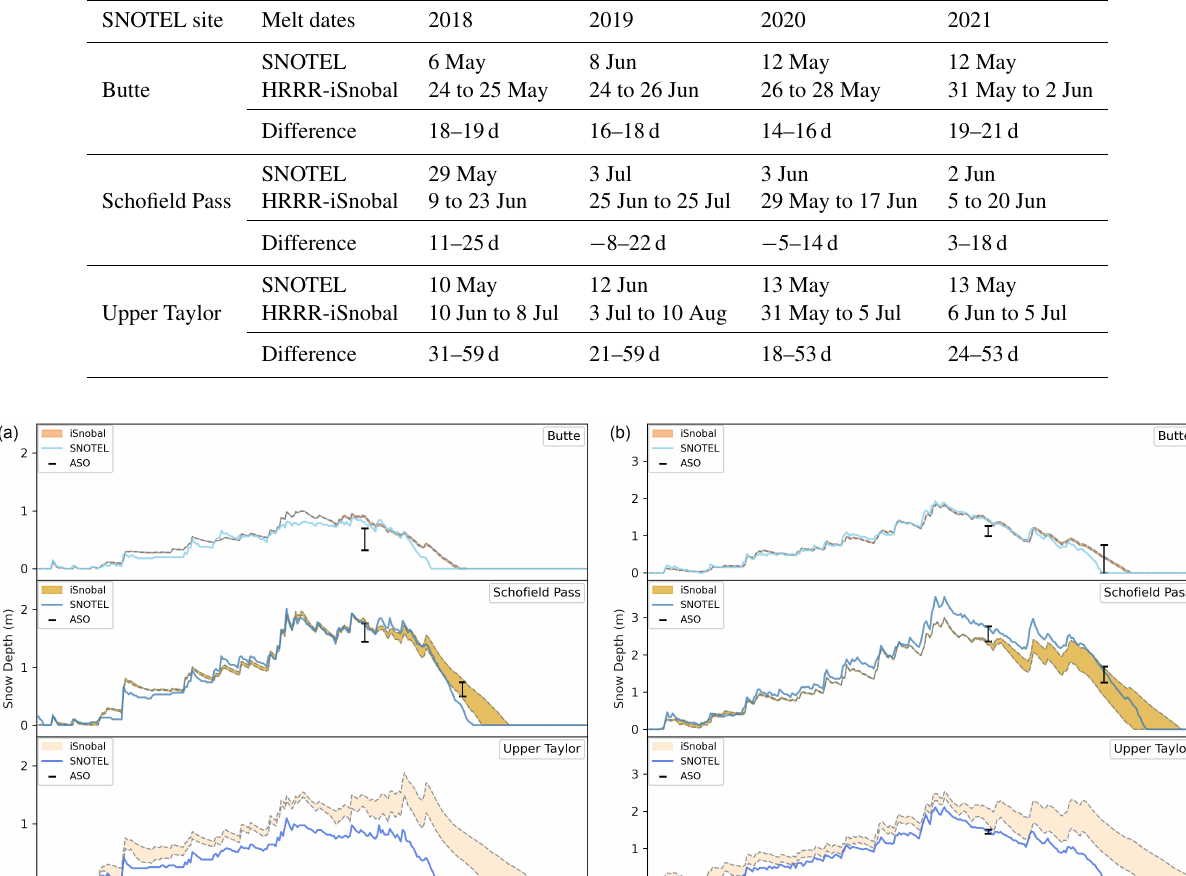
Table 1. Overview of date differences for the last day with snow present between the HRRR-iSnobal and SNOTEL sites.